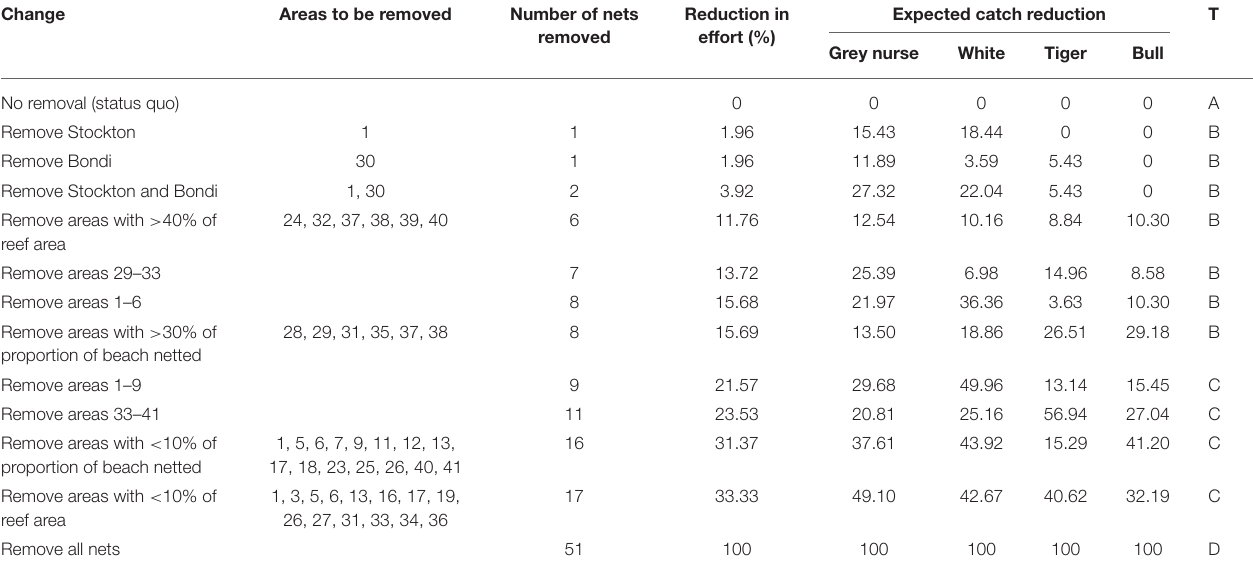
TABLE 1 | Potential changes to the Shark Meshing Program fishing effort, based on the significant variables identified by the fine-scale modelling approach. Change Areas to be removed Number of nets